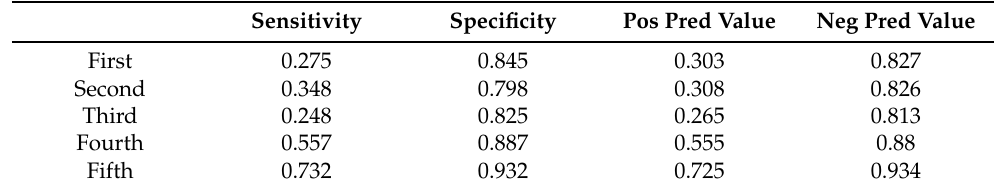
Table 4. Sensitivity, Specificity, PPV, and NPV concerning SCs’ execution times